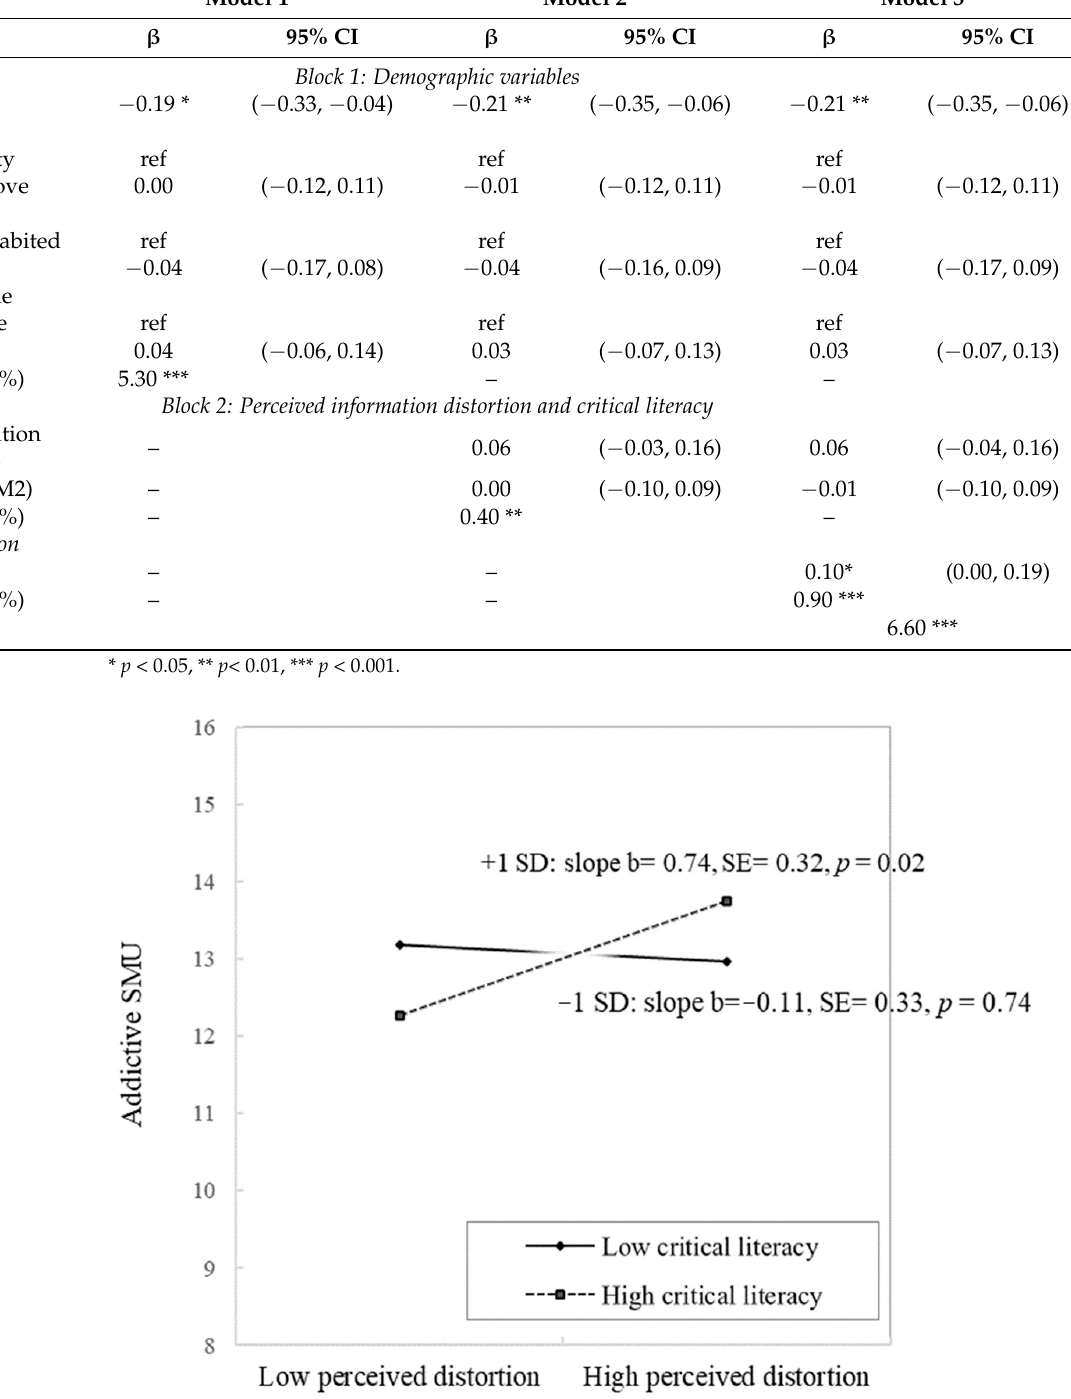
Figure 2. Interaction between perceived information distortion on social media and critical literacy on addictive SMU (N = 411).